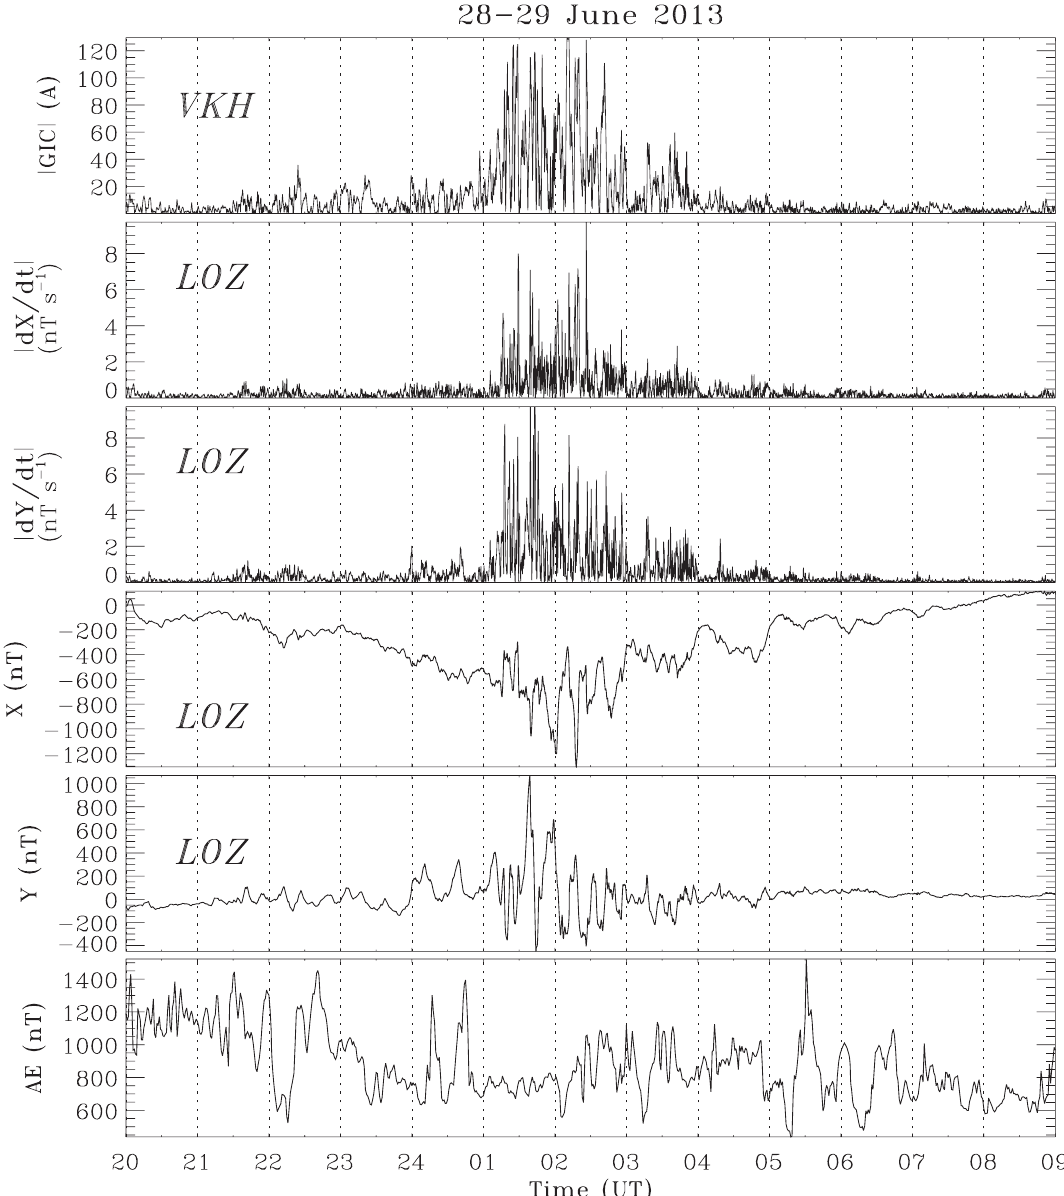
Fig. 13. Comparison between GIC amplitude [A] (10-s cadence), amplitudes of the time derivatives |d X /d t | and |d Y /d t | [nT s (cid:1) 1 ], and X and Y components of geomagnetic fi eld [nT] at LOZ (closely spaced to VKH) between 20 UT on 28 June 2013 and 09 UT on 29 June 2013 (10-s cadence). The bottom panel shows variations of the 1-min AE